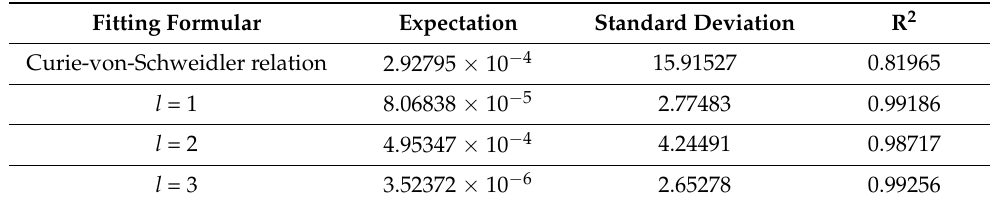
Table 1. Fitting parameters of different formulars. Fitting